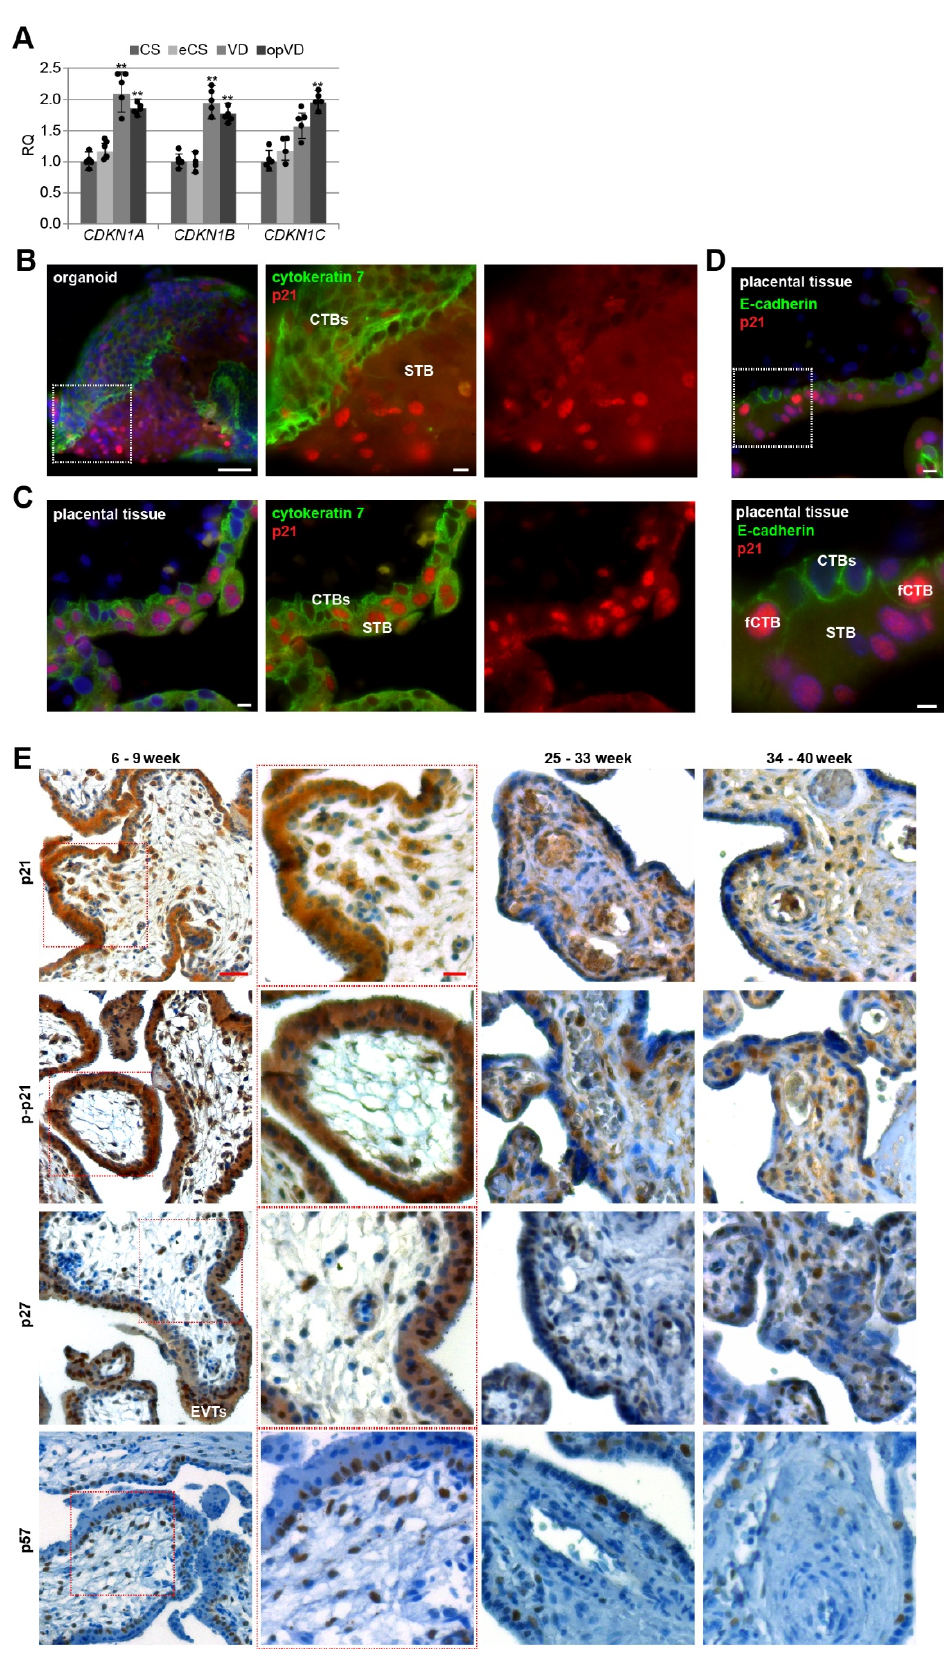
Figure 1. Cell cycle regulators are affected by the delivery mode, and expressed in trophoblast organoids and placental tissues. ( A ) The relative amount of the gene levels of CDKN1A (p21), CDKN1B (p27), and CDKN1C (p57) was analyzed in placental tissues from different delivery modes ( n = 5).